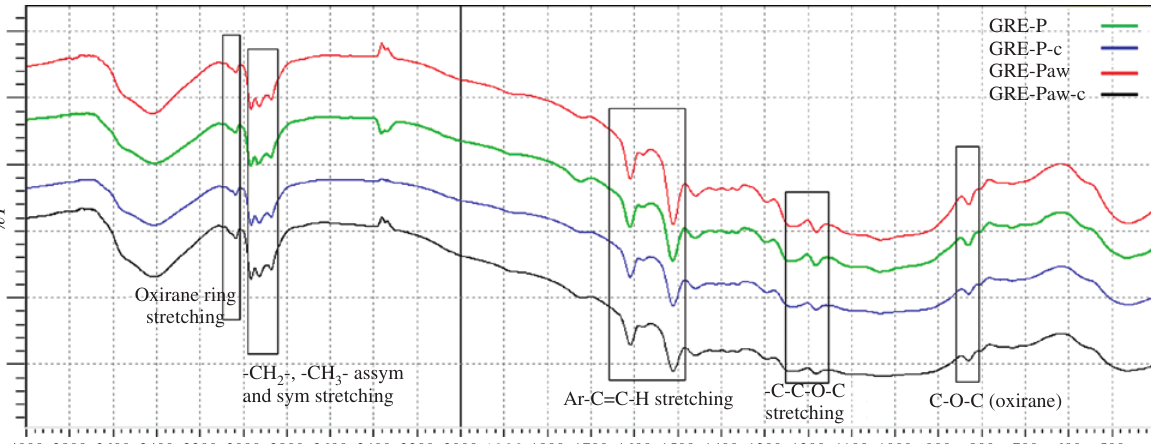
Figure 1: FTIR spectrum of GRE-P and GRE-Paw aged in wet crude.